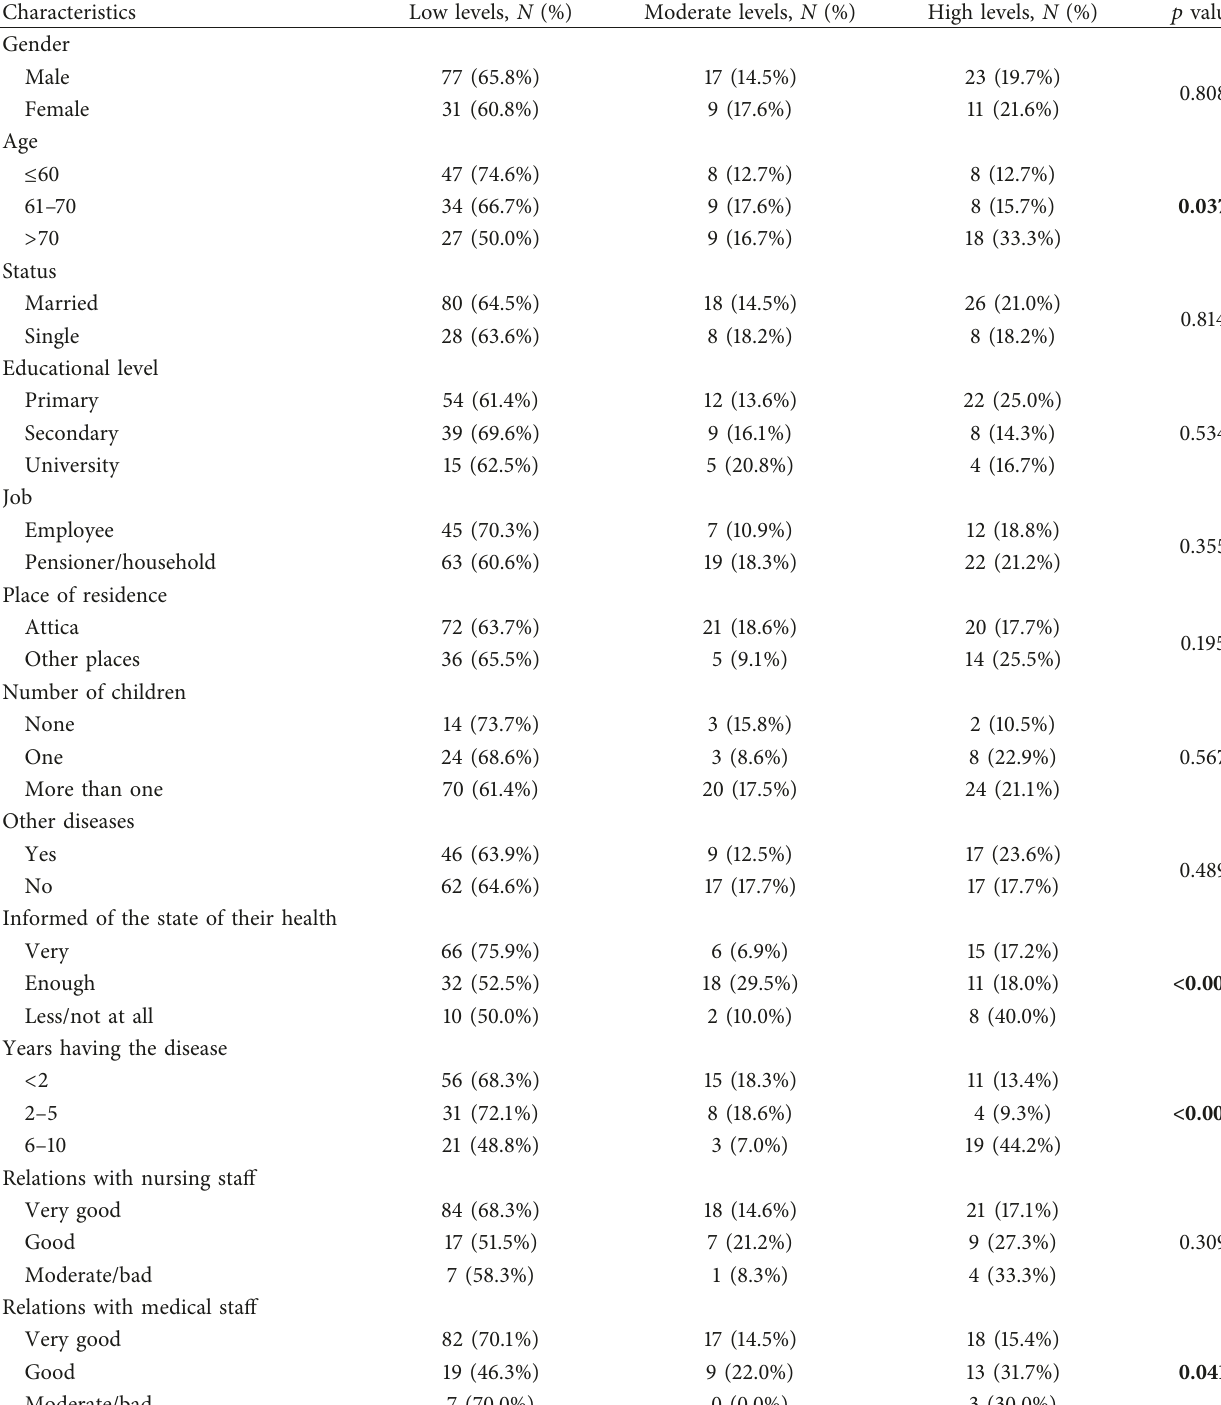
Table 4: Association between patients’ characteristics and depression